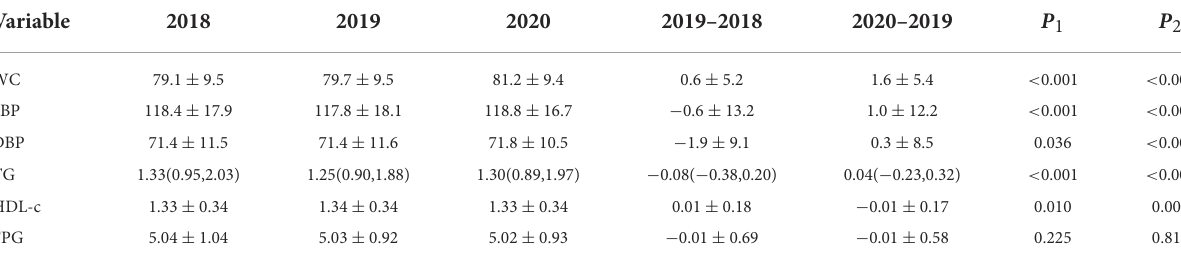
TABLE 4 The impact of the COVID-19 lockdown on MetS component